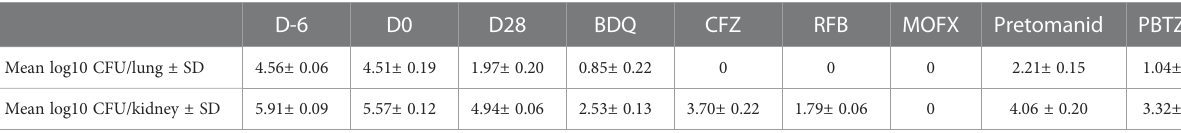
All groups began with equivalent lung implantation burdens.